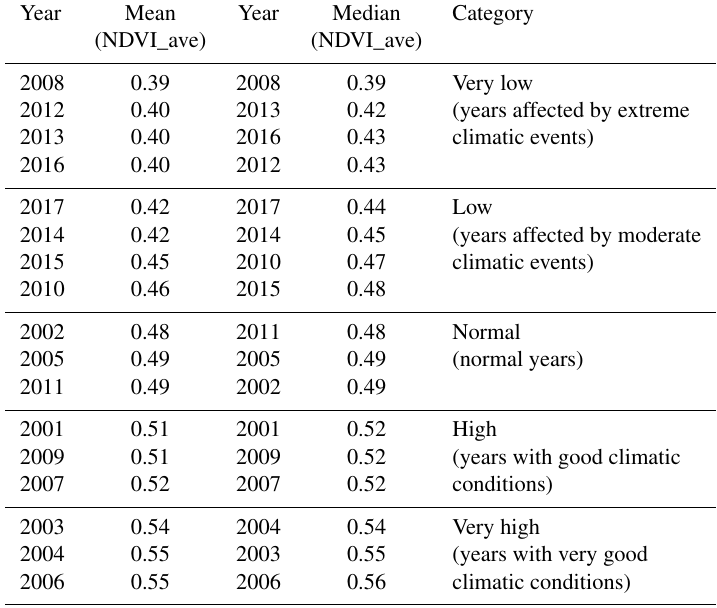
Table 3. Fisher’s least significant difference (LSD) test for comparing means, and Bonferroni test for comparing medians, for years.